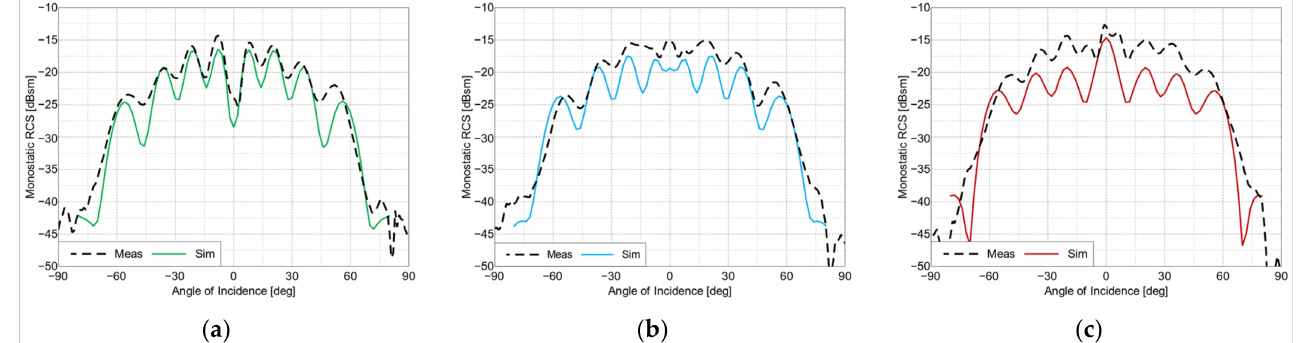
Figure 10. RCS values of the co-polarized arrays vs. angle of incidence, at frequencies of: ( a ) 57 GHz, ( b ) 62 GHz and ( c ) 67 GHz.